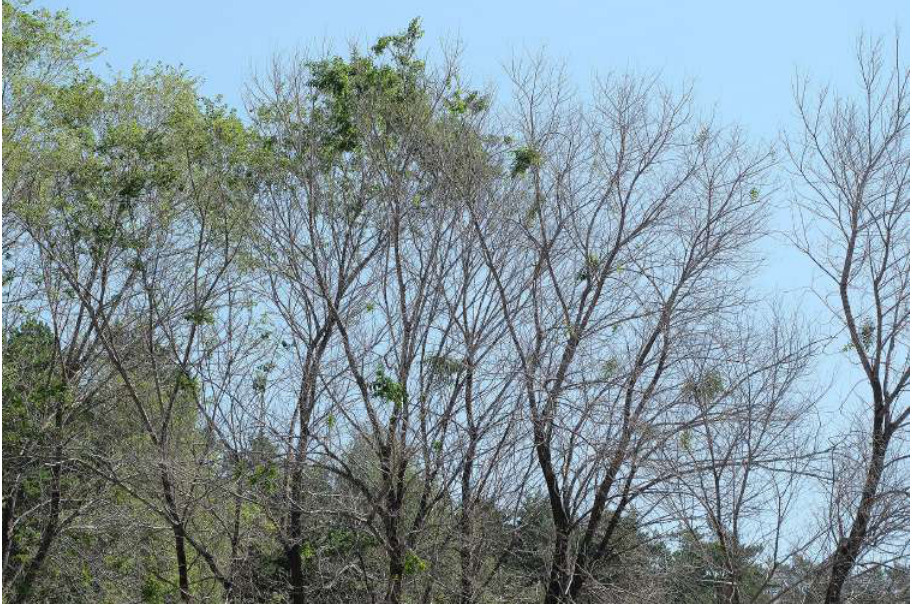
Figure 3. Trees ( Ulmus pumila ) damaged by Ambrostoma superbum from Lesosechnaya str.